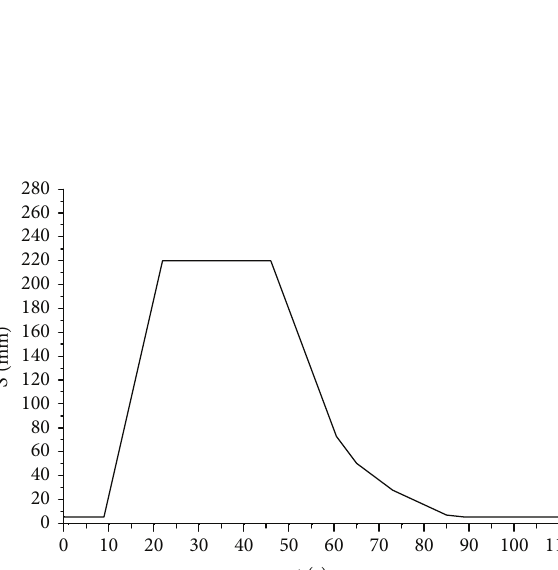
Figure 19: Pressure in pipeline.